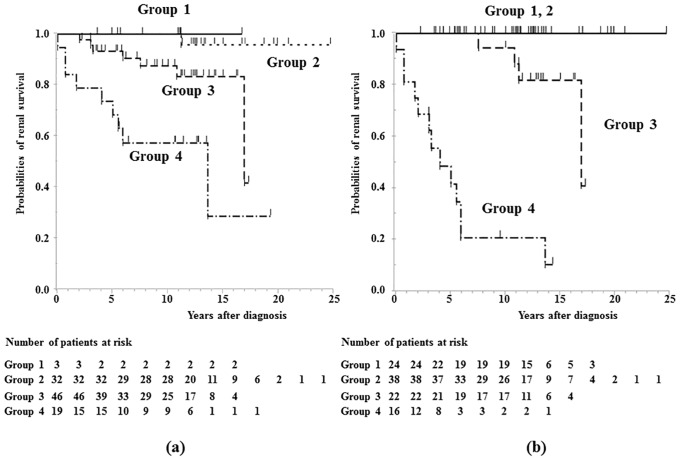
Survival curve showing time to CRI.a) Kaplan-Meier plot showing time to CRI stratified by proteinuria at diagnosis. b) Kaplan-Meier plot showing time to CRI stratified by proteinuria during follow-up period. group 1, no proteinuria (<0.2 g/day/1.73 m2); group 2, mild proteinuria (0.2–1.0 g/day/1.73 m2); group 3, heavy proteinuria without hypoalbuminemia (>1.0 g/day/1.73 m2 with serum albumin level ≥3.0 g/dL); group 4, heavy proteinuria with hypoalbuminemia (>1.0 g/day/1.73 m2 with serum albumin level <3.0 g/dL).